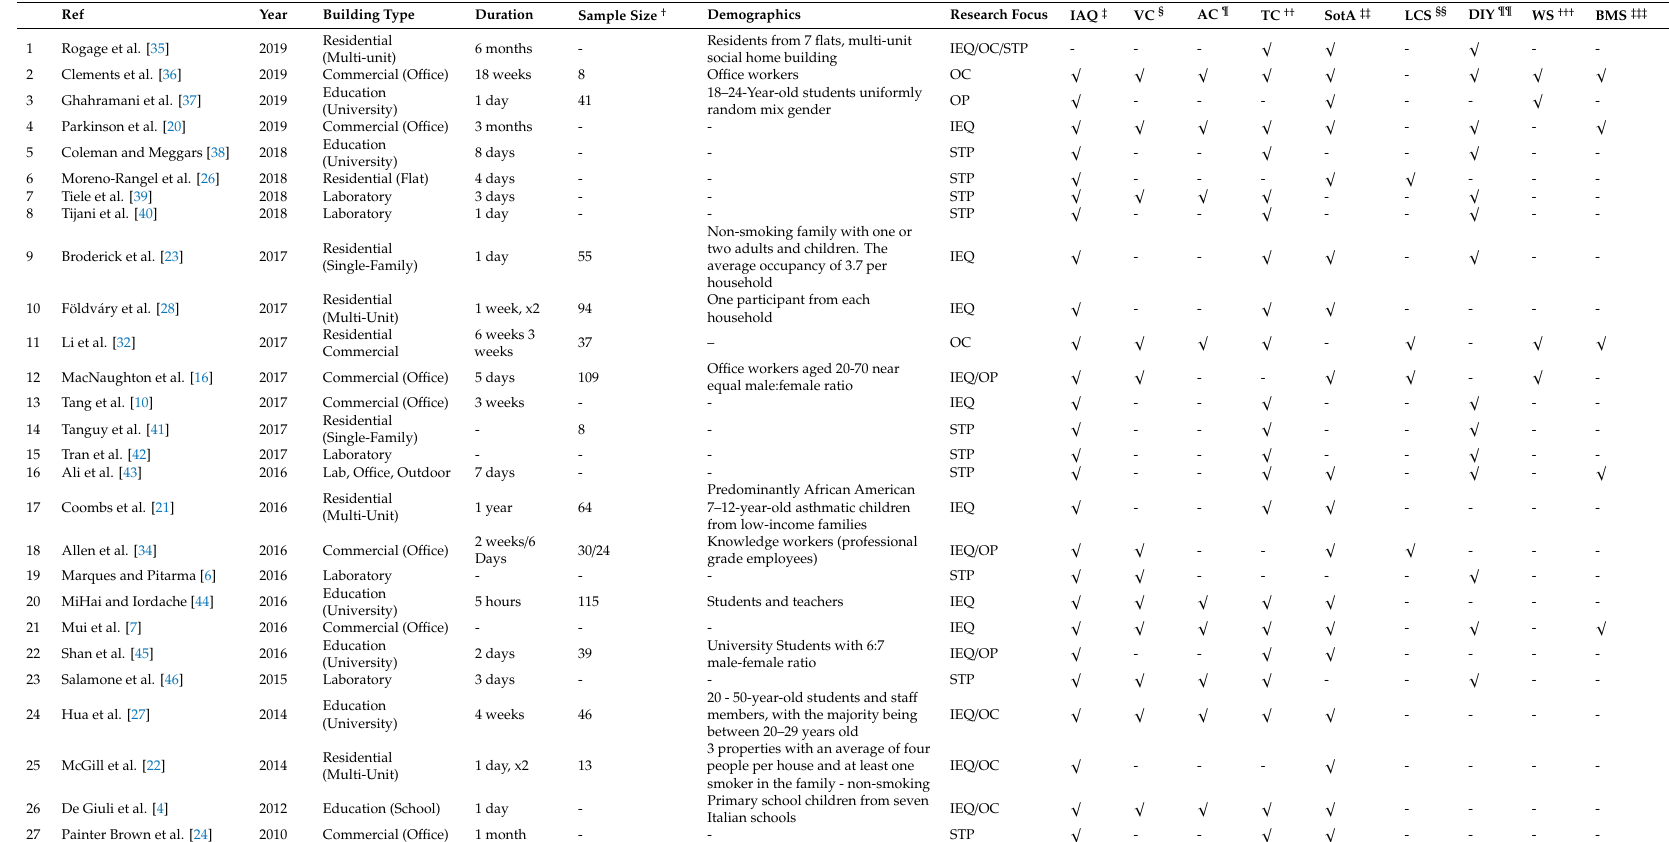
Table 2. Overview of Measurements in Selected